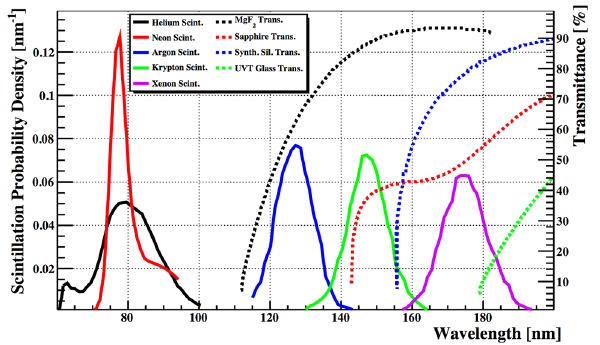
Fig. 1 Scintillation wavelengths for various noble gases, along with the transmission of some commonly used optical windows [16] 120–250 nm [16]. The WLSE as defined in [16] is a “black-